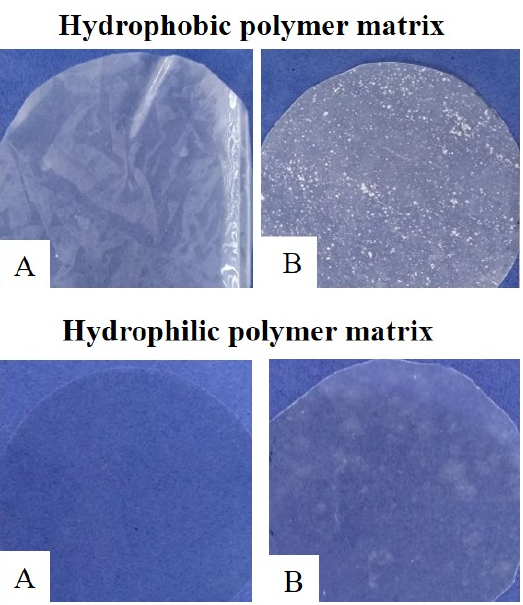
Figure 4. Inclusion complex (IC) of EO and β -CD incorporated into: cellulose acetate matrix (hydrophobic) and methylcellulose matrix (hydrophilic). ( A ) control film; ( B ) film incorporated with the IC.